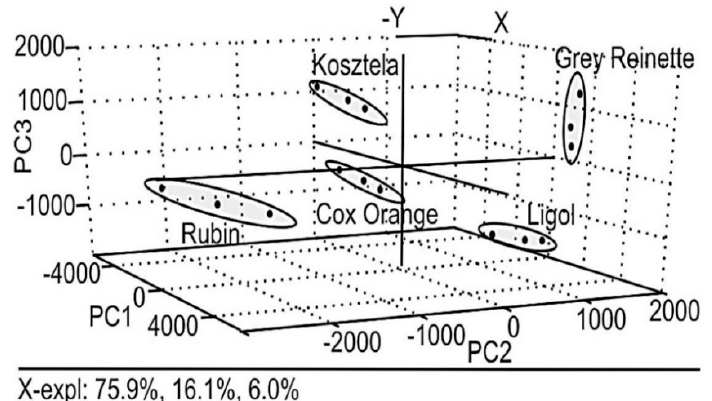
Figure 3. Scores plot obtained in the PCA treatment of cyclic voltammetric (CV) data (see Figure 2) acquired with four working electrodes in three replicates of five types of apple liqueur (from Ligol, Kosztela, Grey Reinette, Rubin and Cox Orange apples). Reproduced from [43].